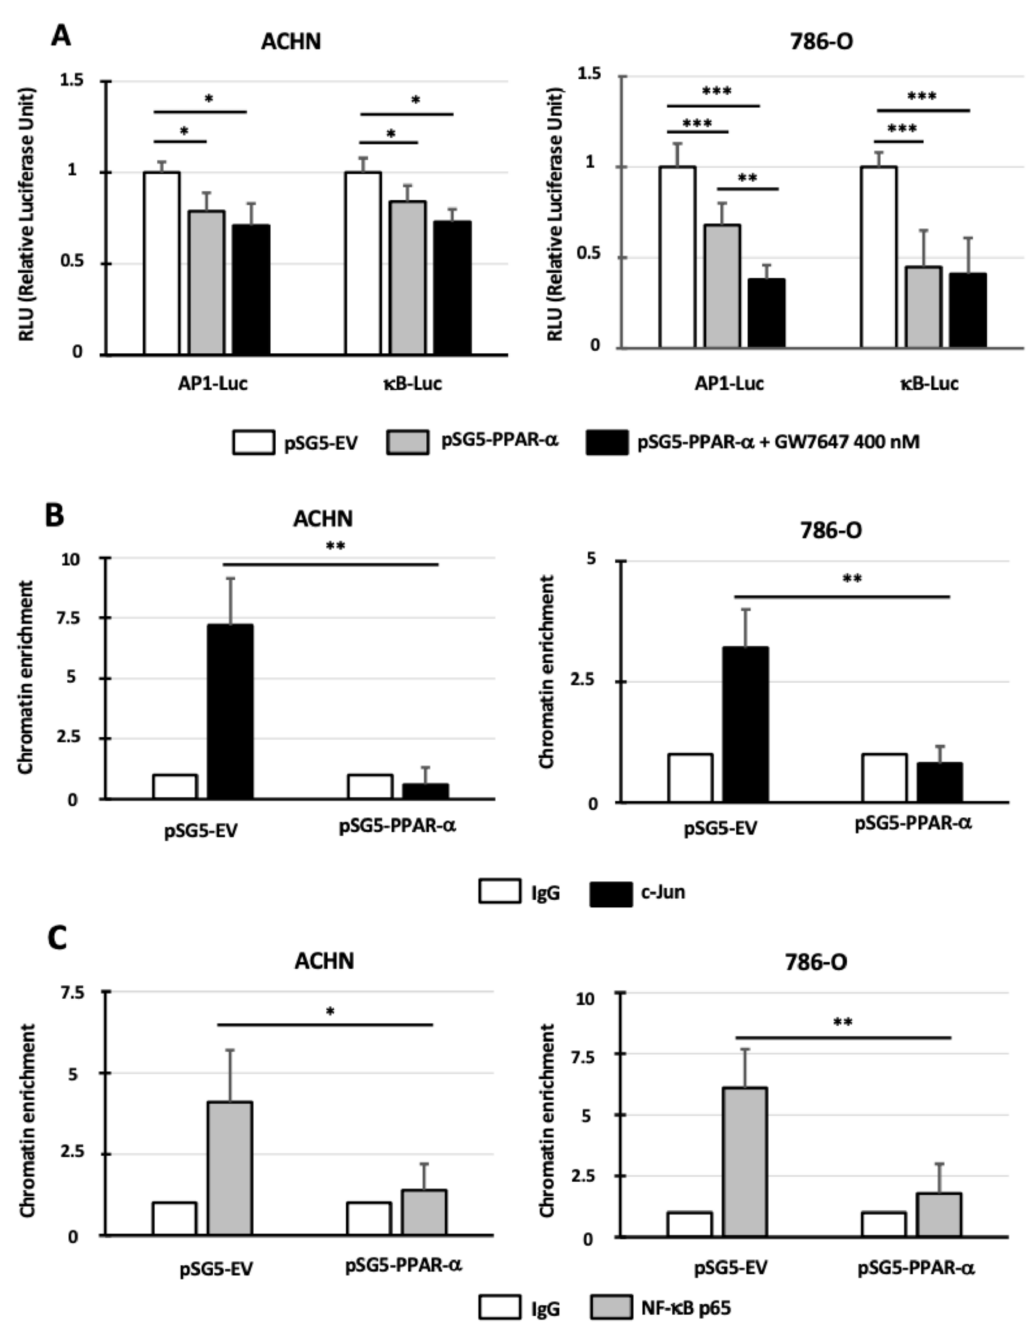
Figure 4. PPAR- α expression and/or activation decreases AP-1 and NF- κ B transcriptional activity and binding to miR-21 promoter. ( A ) ACHN and 786-O cells were co-transfected with pSG5-EV (empty vector) or pSG5-PPAR- α expression vectors and κ B-Luc or AP1-Luc synthetic promoters. At 24 h after transfection, the cells were incubated with 0 or 400 nM of GW7647. At 48 h after transfection, luciferase activity was measured. Luciferase activity in cells transfected with pSG5-EV was set as